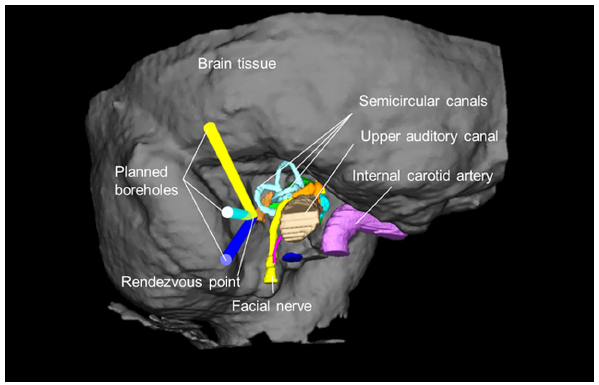
Figure 1. Concept of multiport image-guided minimally invasive surgery to the lateral skull